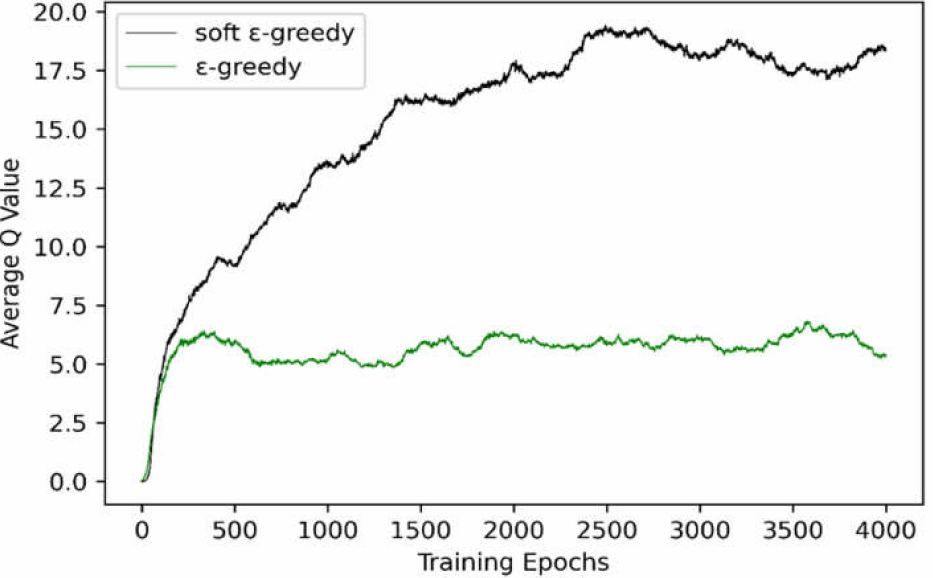
Figure 4. Average maximum predicted action value Q for each training